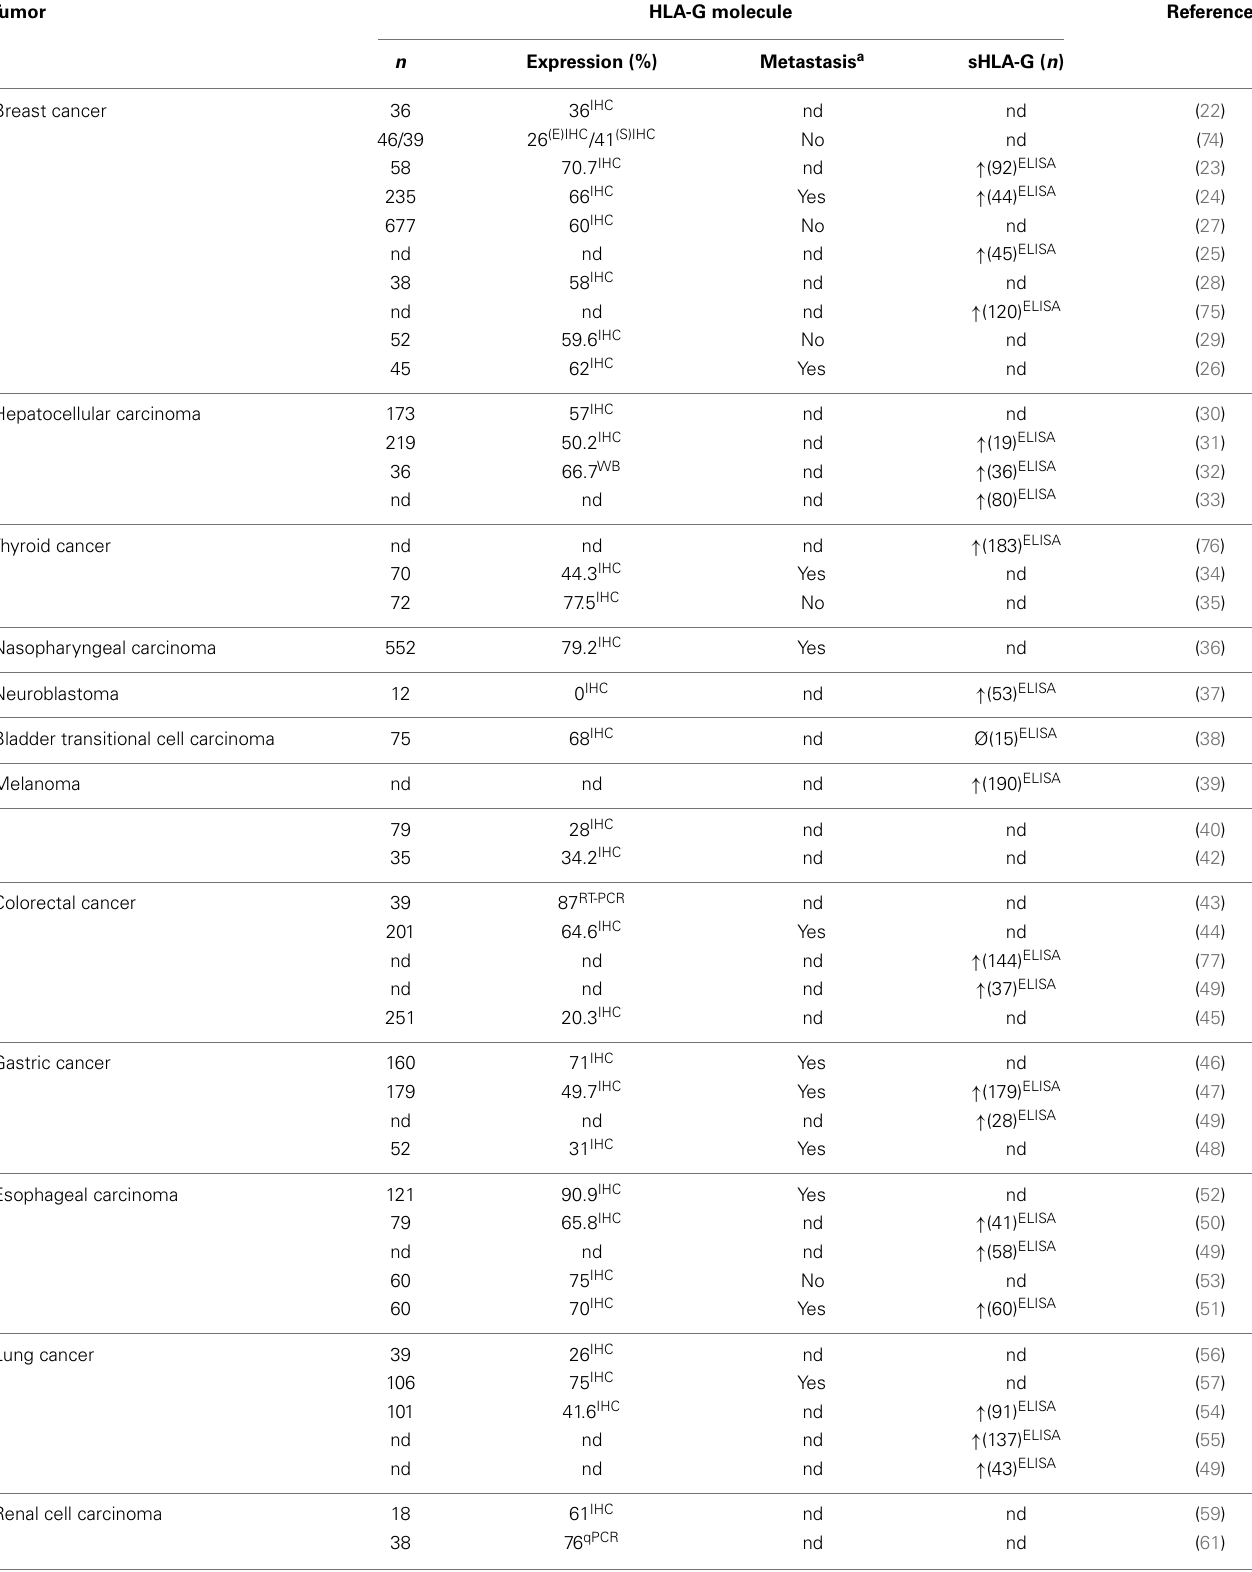
Table 1 |Association between HLA-G expression and tumors . Tumor HLA-G molecule